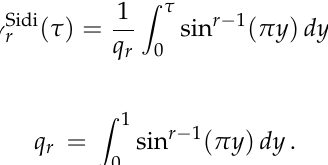
Table 4. Relative errors of the N -point Gauss-Legendre quadrature rule corresponding to the Doblaré-Gracia transformation Q DG ( t ) and the presented transformation F ( η ; t ) for the CPV integral K φ ( s 0 ) , 0 ≤ s 0 ≤ 3 in Example